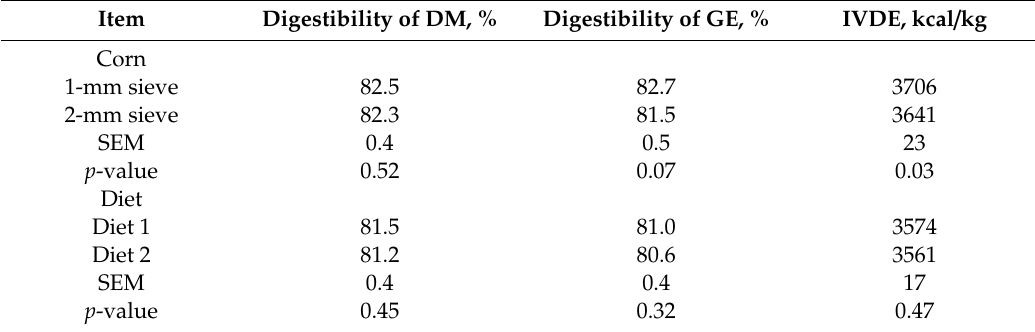
Table 5. E ff ect of particle size on in vitro digestibility a of DM, GE, and IVDE b in corn and diets (dry-matter